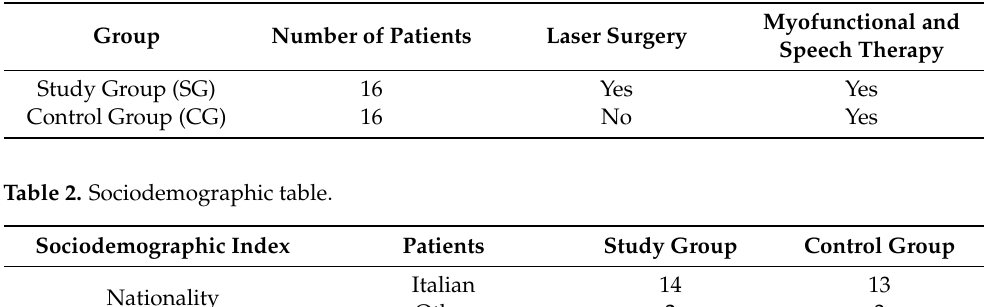
Table 1. Summary of data for each group.